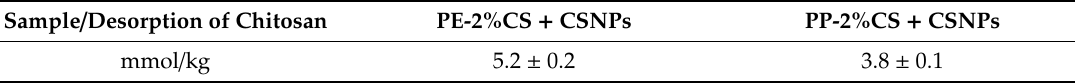
Table 3. Desorption of chitosan amino group per kilogram of foil.